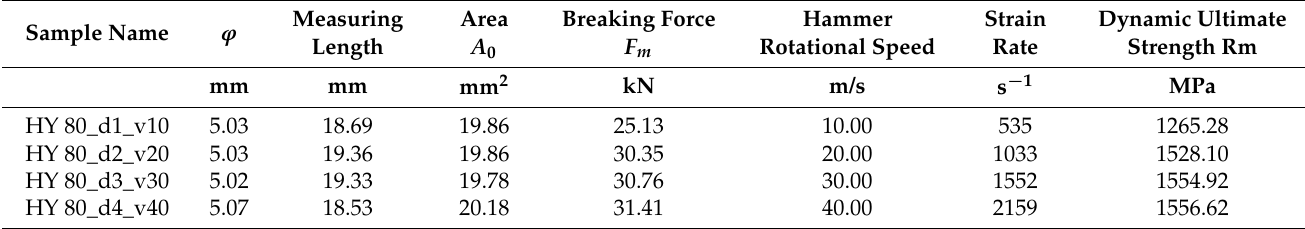
Table 1. Summary of test results on a rotary hammer.